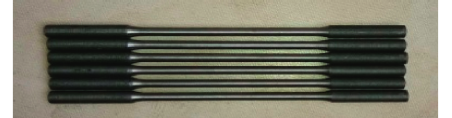
Figure 3: Photo of uniaxial tensile specimens of gray cast iron HT200.